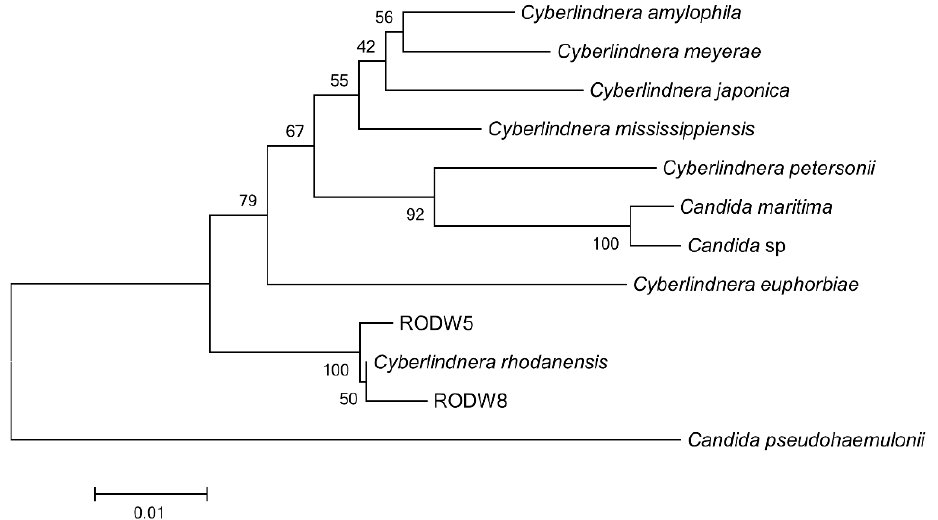
Figure 2. Taxonomic affiliation of indigenous yeast RODW isolates. A neighbor-joining phylogenetic tree constructed from 18S-rRNA, 26S-rRNA and TEF1 α sequences of RODW5 and RODW8 isolates and BLAST search-identified sequences showing a higher level of homology.